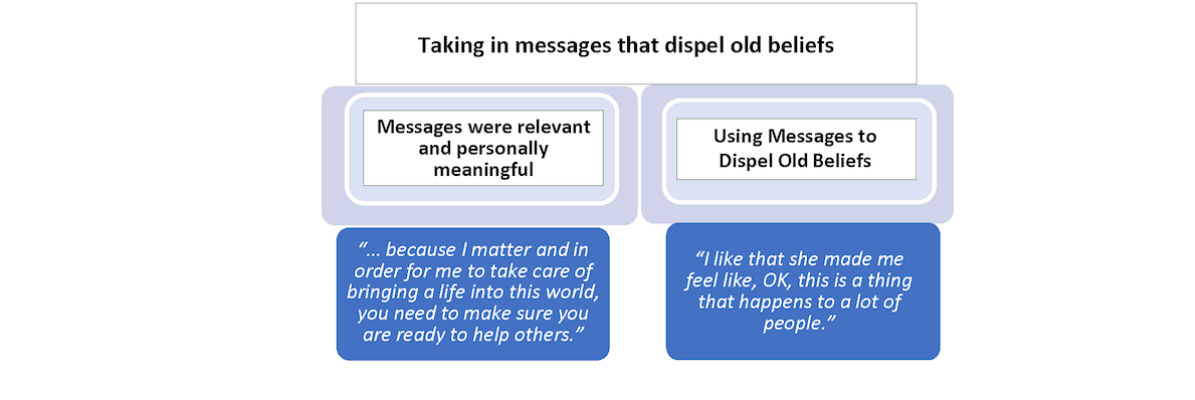
Messages Were Relevant and Personally